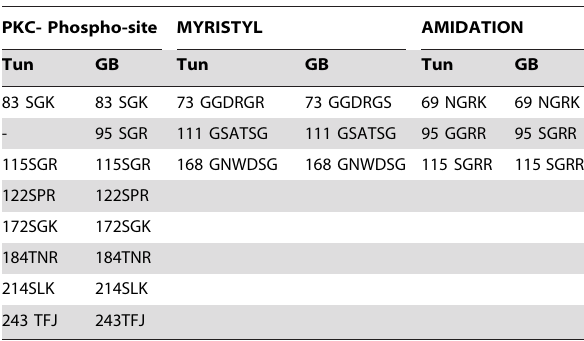
Table 2. Putative post-translational modification sites present in the amino acid sequence of Tunisian PpSP32 versus the protein described in